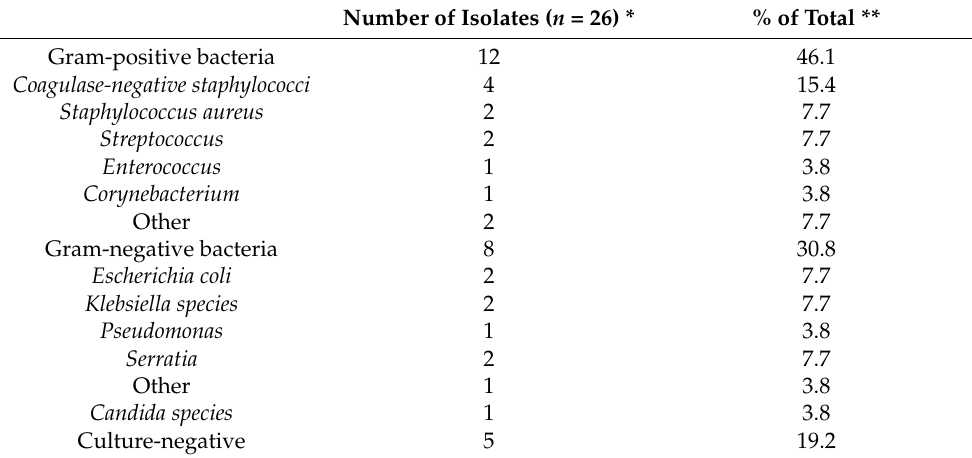
Table 4. Characteristics of identified microorganisms and